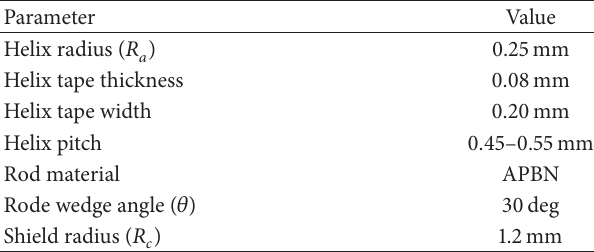
Table 1: Parameters of the helix slow-wave